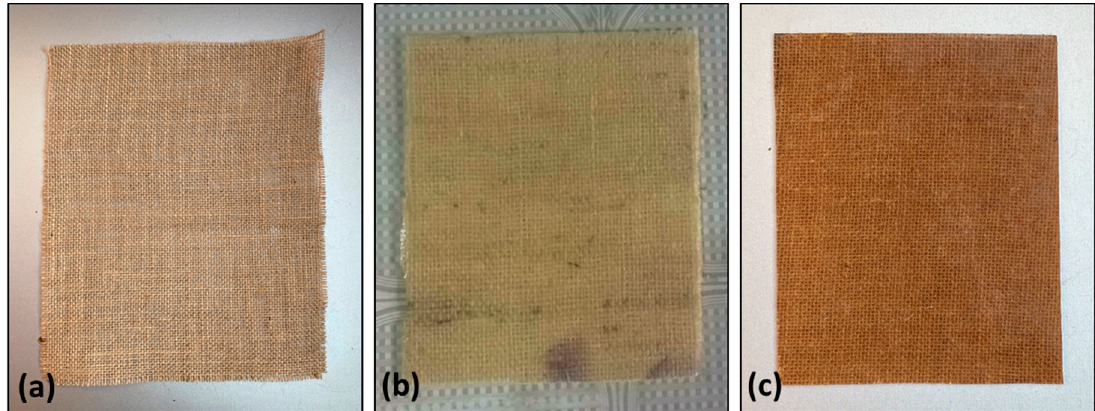
Figure 1. Photographs of ( a ) reinforced jute fabric, ( b ) resultant Jute / PR composites, and ( c ) resultant Jute / Epoxy composites.